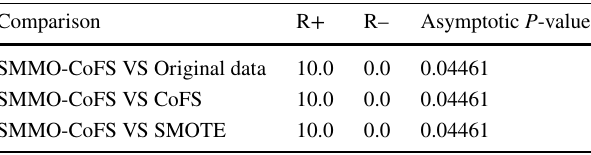
Fig. 8 Performance of SMMO-CoFS with random forest, J48, BayesNet and AdaBoostM1 in terms of processing time Table 8 The result of Wilcoxon statistical significance test in terms of TPR with a significance threshold of 𝛼 = 0.05, sum of signed ranks R + R − and , and P -values Comparison R+